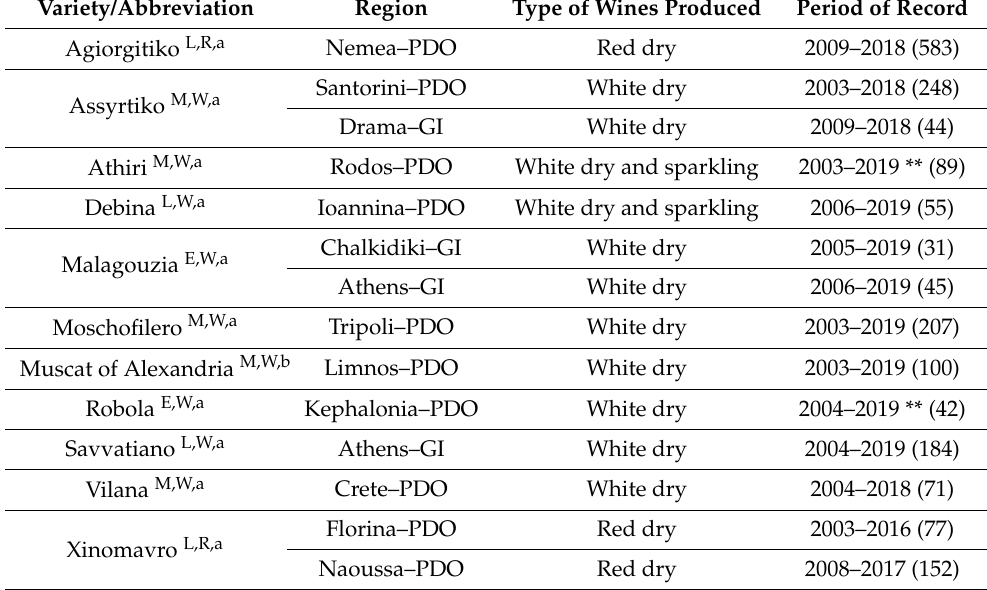
Table 1. Details for the 11 principal winegrape varieties (10 indigenous and 1 international) cultivated in 13 principal winegrape areas in Greece. Varieties and regions are presented in the first two columns. The predominant type of wine produced per region, the period of records and the respective total number of wines used per variety, are given in the last two columns. Each variety has superscript letters indicating indigenous (a) and international varieties (b); early (E), mid (M), and late (L) season varieties [24]; and red (R) and white (W) varieties. ** correspond to two missing wine quality scores on each